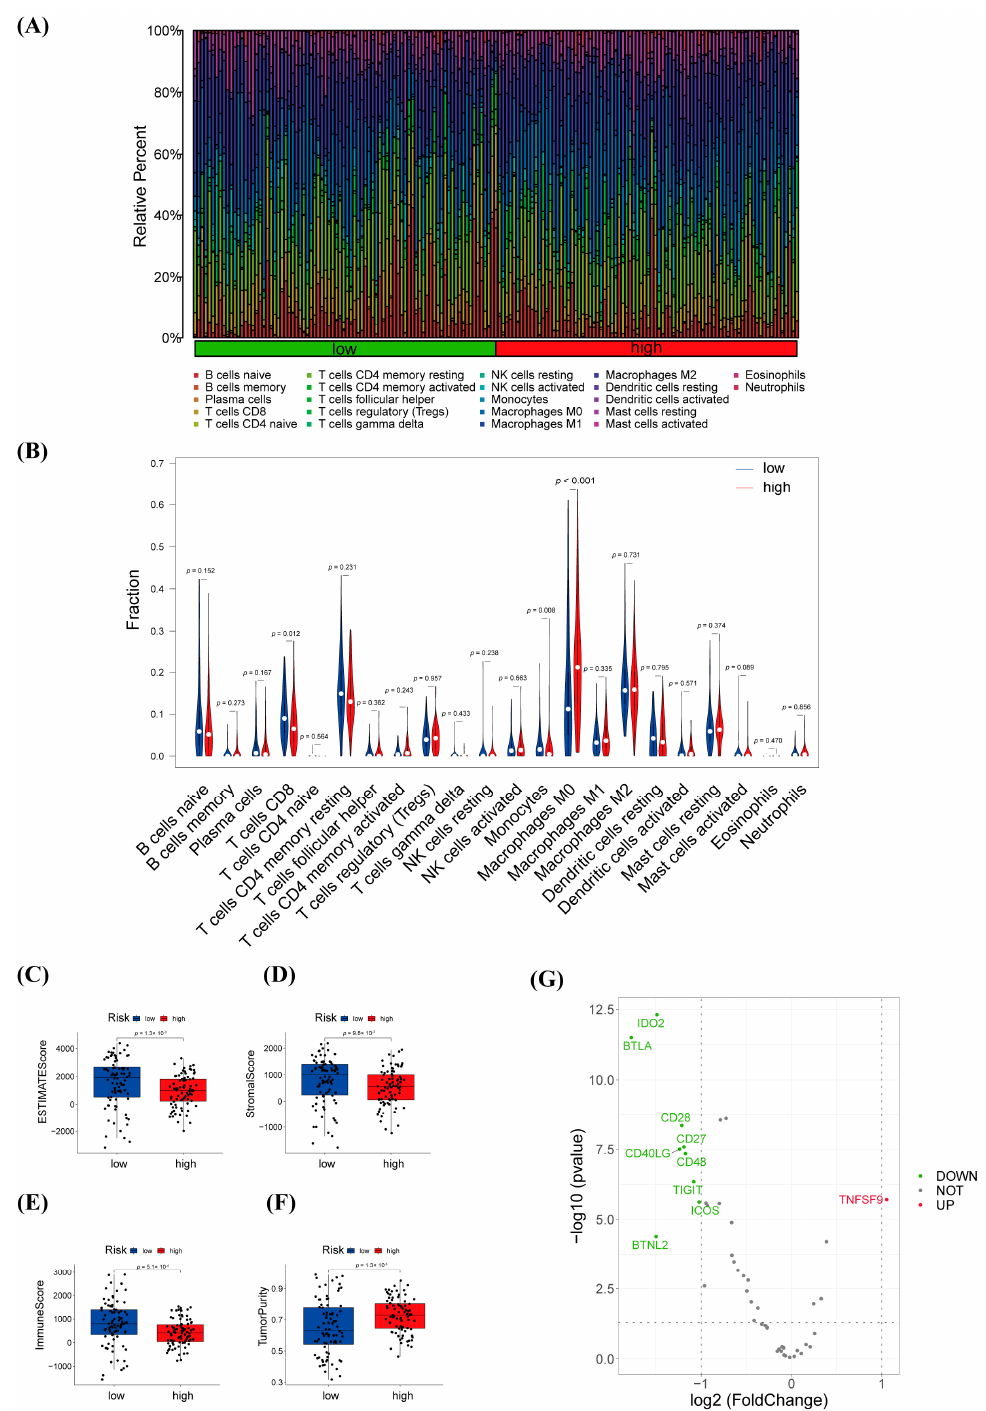
Figure 7. Identification of immunotherapeutic response based on warlncRNAs signatures. ( A , B ) The percentage proportion ( A ) and infiltration ( B ) of 22 immune cells between high- and low-risk groups in the training cohort. ( C – F ) Differential analysis of ESTIMATE ( C ), stromal ( D ), immuneScore scores ( E ), and tumor purity ( F ) according to ESTIMATE analysis between high- and low-risk populations in the training cohort. ( G ) The differential expression of 47 immune checkpoints between the high- and low-risk